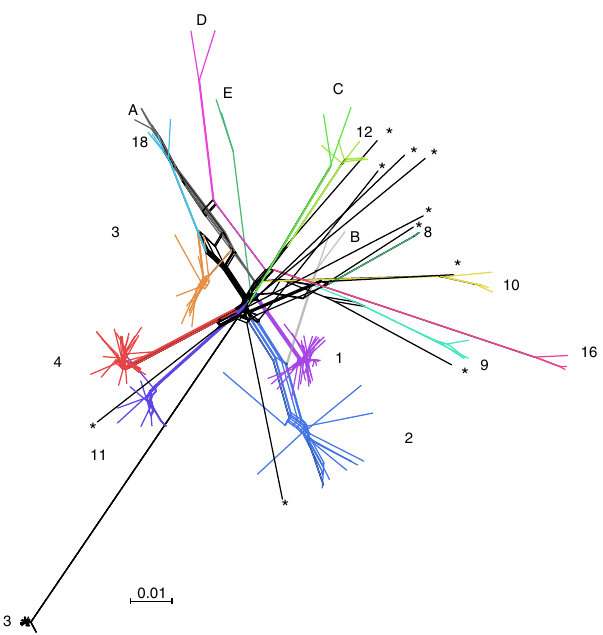
Fig. 3 Neighbor-net of Candida albicans . Neighbor-net analysis for 182 isolates collected worldwide based on SNP data. Reticulation indicates likely occurrence of recombination. Branch lengths are shown and the scale bar represents 0.01 substitutions per site. Asterisks pinpoint strains which could not be assigned to any genetic